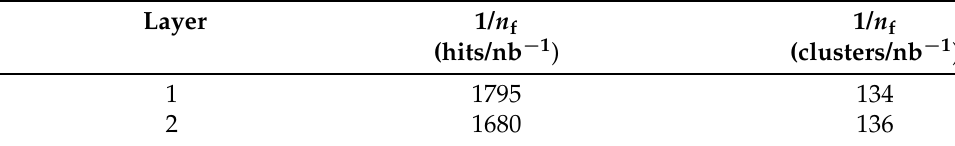
Table 32. Approximate normalization (1/ n f ) to convert hit and cluster rates to luminosities. Taken from Ref.